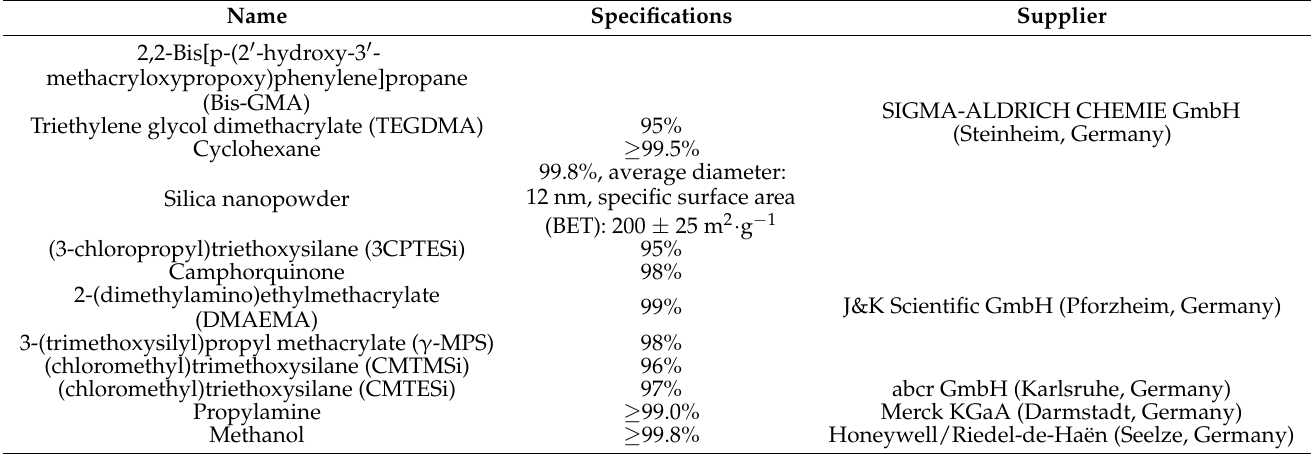
Table 1. Chemicals utilized for the modification of nanosilica and the synthesis of dental nanocomposite